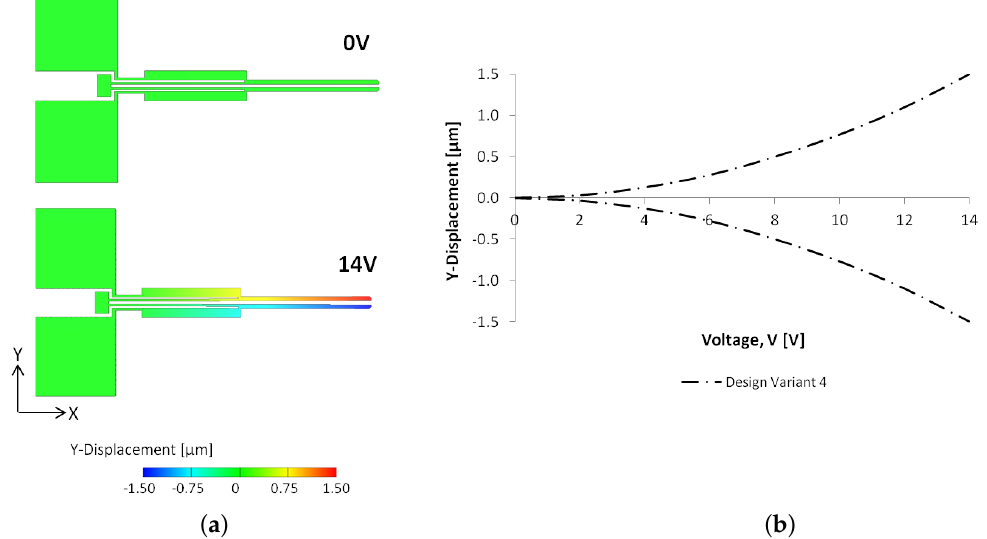
Figure 12. Simulated steady-state lateral displacement distribution on the single crystal silicon microgripper structure fabricated with SOIMUMPs TM (Design 4): simulated y -displacement plots showing the distribution with and without an applied potential ( a ); and variation of the relative opening stroke of each microgripper arm tip with applied voltage ( b ). The absolute gap opening in the closed position is 5 µ m with this absolute gap increasing to 8 µ m at 14 V.